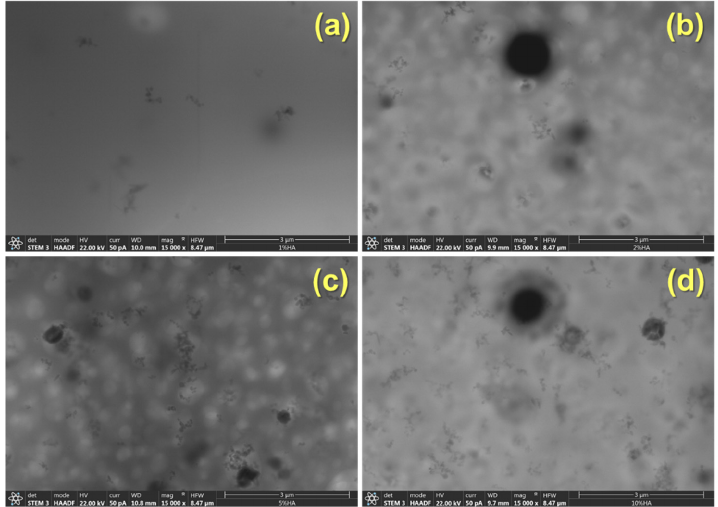
Figure 6. STEM images at medium magnification of the PSF/HA nanocomposites under study: ( a ) 1%; ( b ) 2%; ( c ) 5%; and ( d ) 10% wt of HA, respectively.